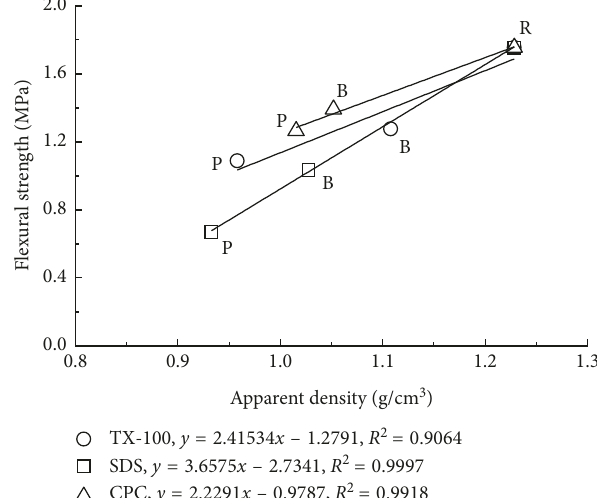
Figure 9: Flexural strength results of pastes blended with and without MWCNT and TX-100, SDS, and CPC after 7 days of curing.